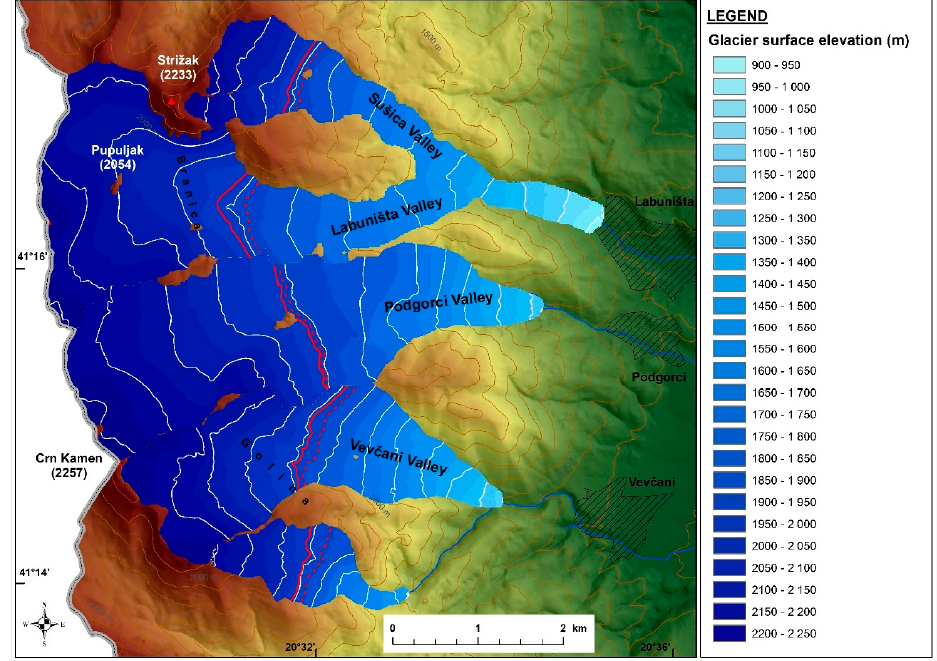
Figure 8. Reconstructed glaciers during Vev č ani phase in the Jablanica Mt. Solid red line indicates the size-specific Accumulation Area Ratio (ssAAR) equilibrium-line altitude (ELA), dashed red line indicates the Area-Altitude Balance Ratio (AABR) ELA.